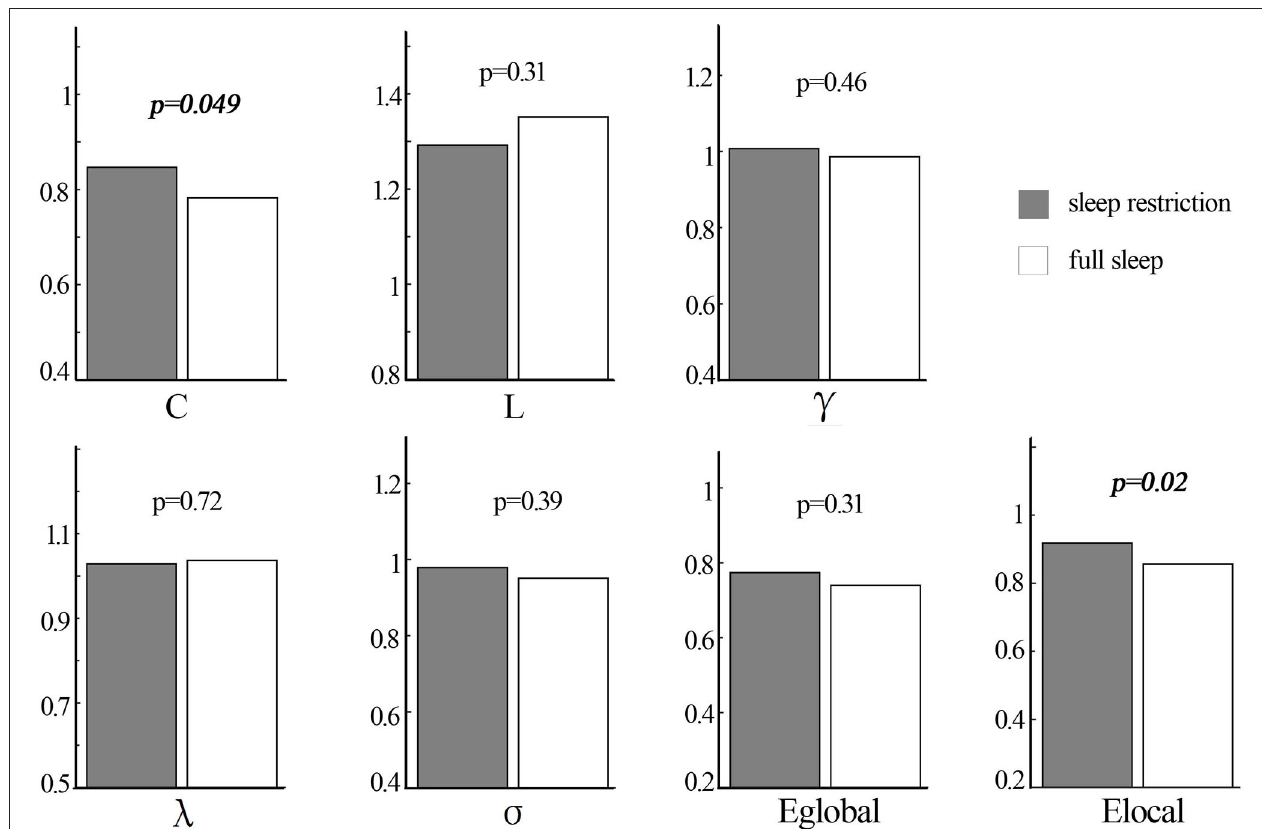
FIGURE 3 | Statistical difference in topological properties of structural covariance network between sleep restriction condition and full sleep condition by using non-parametric permutation test. The clustering coefficient and local efficiency were significantly increased after sleep restriction. C, clustering coefficient; L, shortest path length; Eglobal, global efficiency; Elocal, local